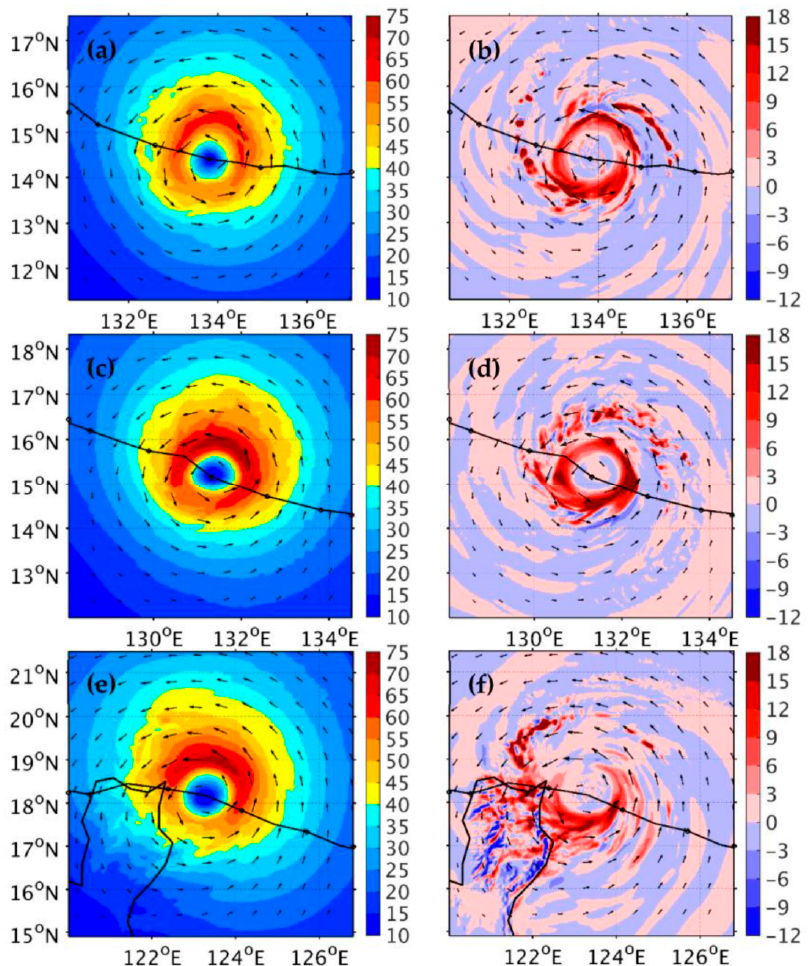
Figure 9. The simulated horizontal wind speed (shaded colors in m s − 1 ) averaged in 1–8 km height for MK-CTL at ( a ) 48 h, ( c ) 60 h, and ( e ) 93 h. ( b ), ( d ), and ( f ) as in ( a ), ( c ), and ( e ), respectively, but for vertical velocity (shaded colors in 10 − 1 m s − 1 ). The black line shows the simulated track with solid cycles at an interval of 6